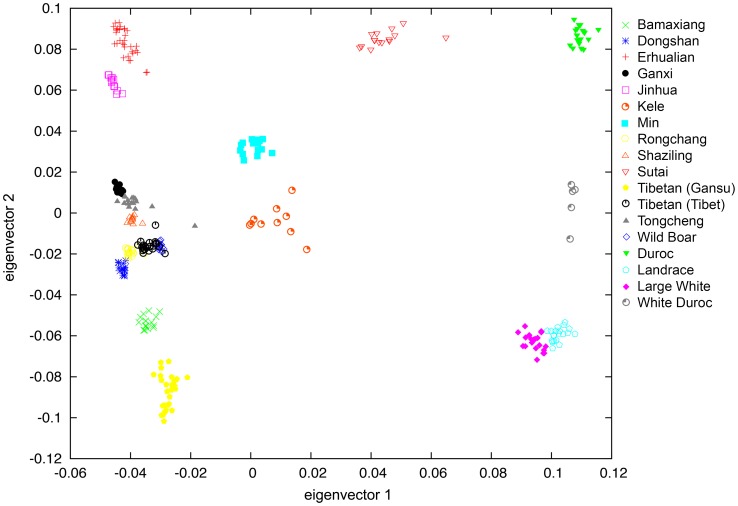
Population structures of Chinese and Western pigs revealed by principal component analysis.